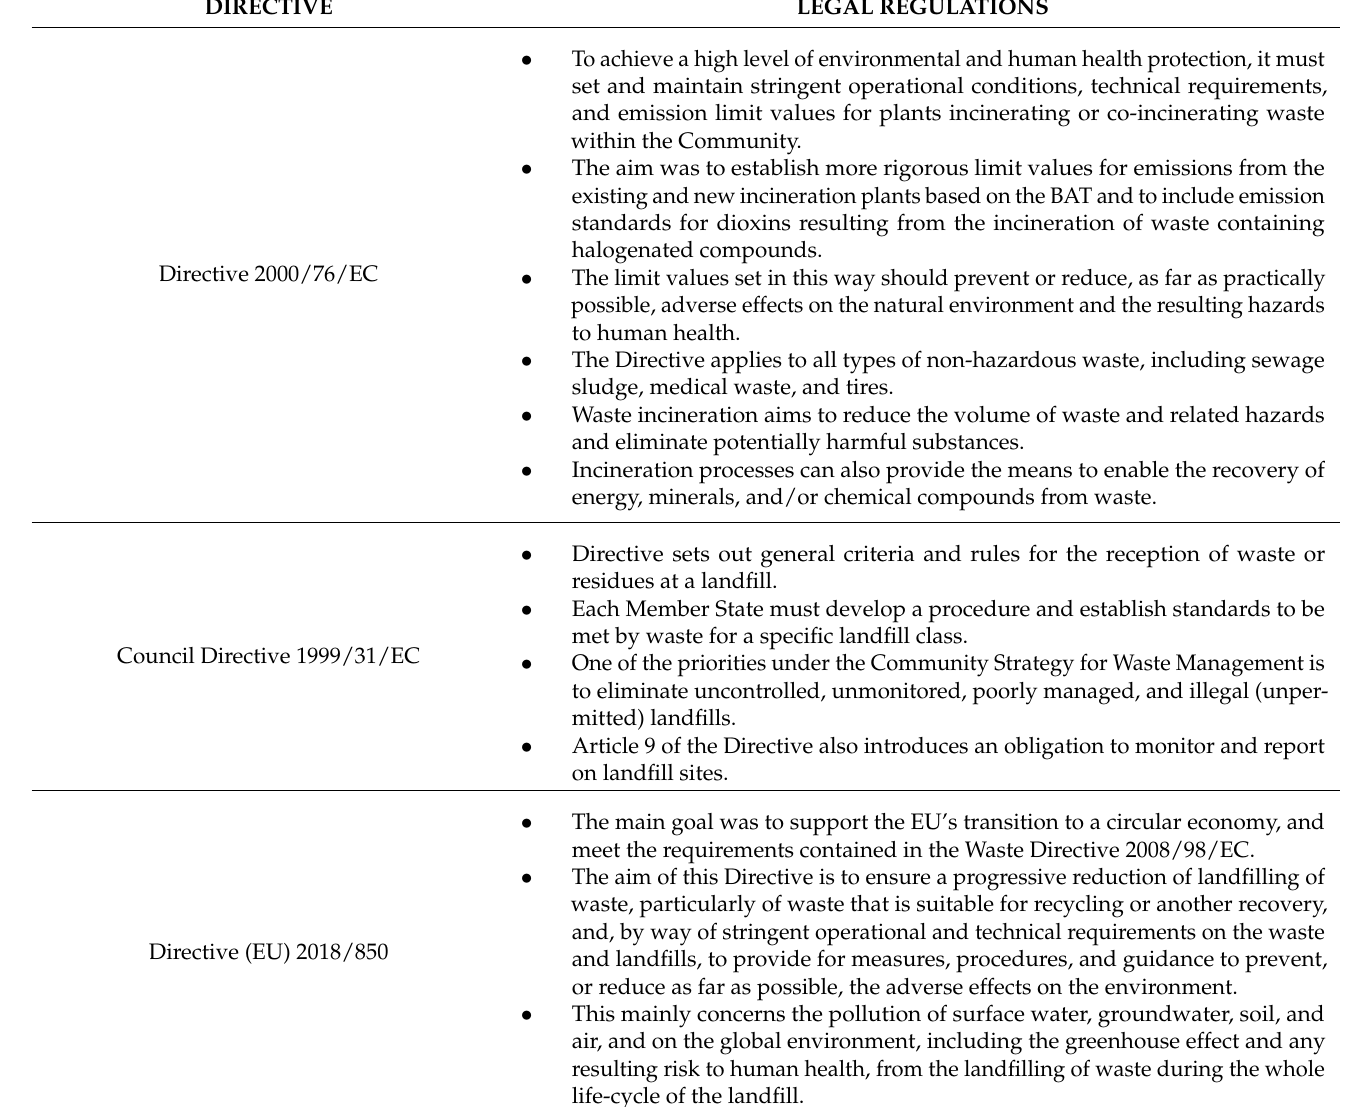
Table 3. Basic principles of waste disposal according to EU